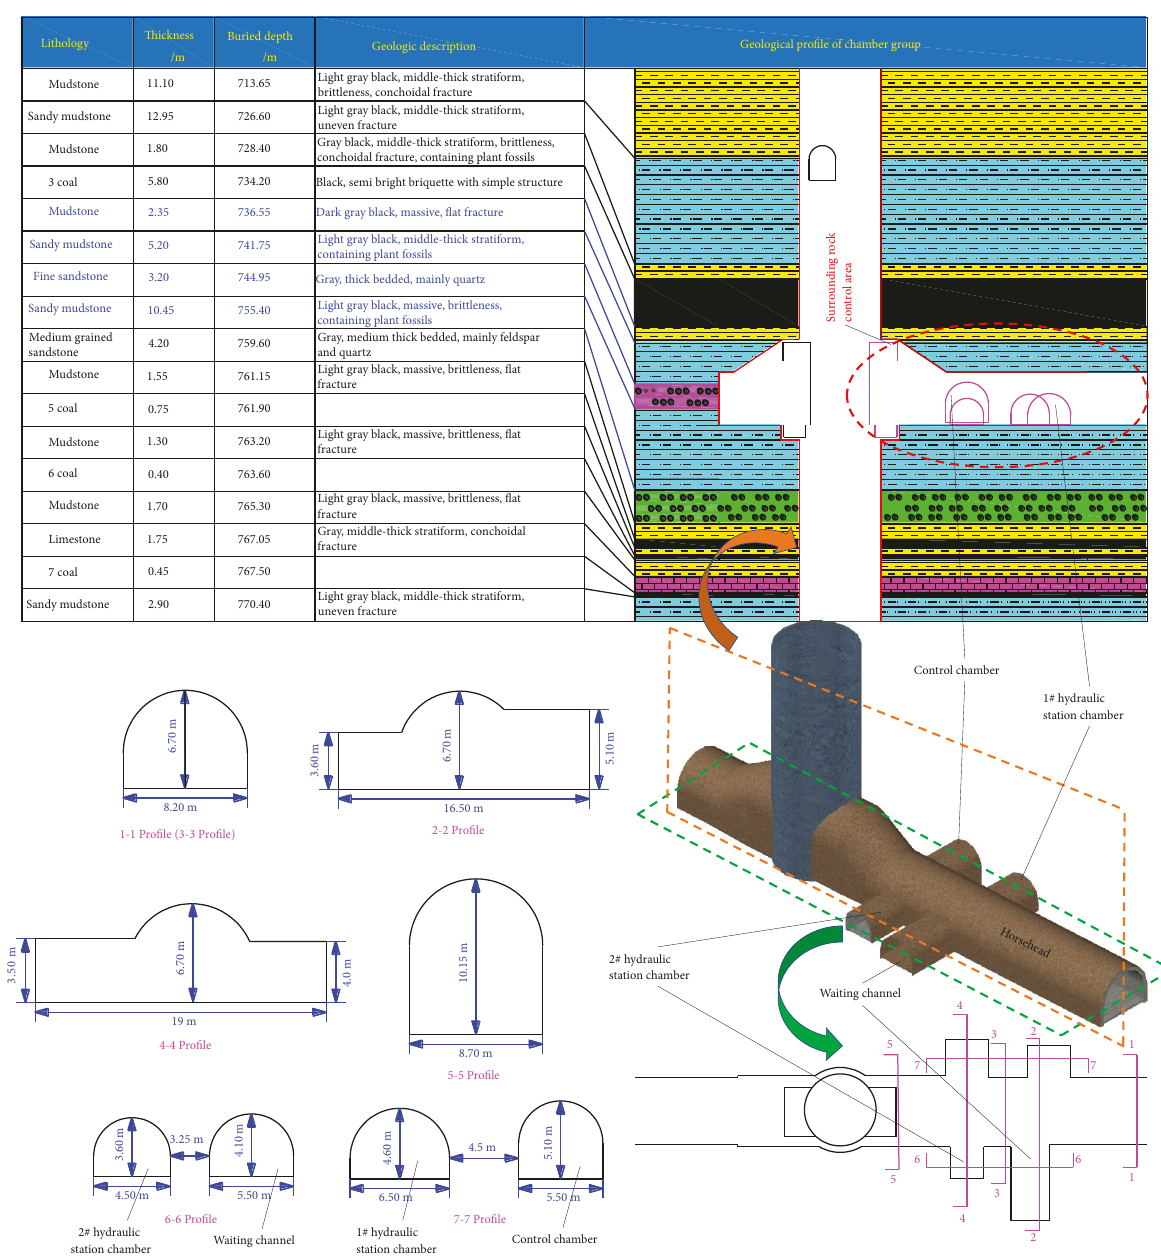
Figure 2: Lithology and parameters of typical large section of chamber